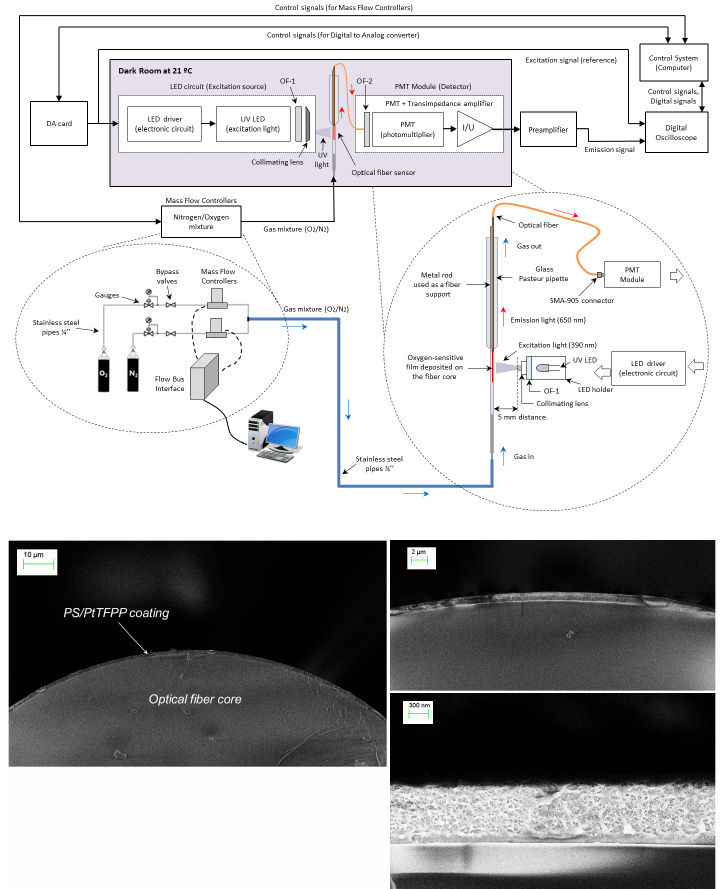
Figure 4. Experimental setup: ( top ) Schematic diagram of the experimental setup including the control system, the gas station, the excitation subsystem, the optical fiber sensor, and the acquisition subsystem; ( bottom ) scanning electron microscope (SEM) images of the optical fiber probe with the PS/PtTFPP